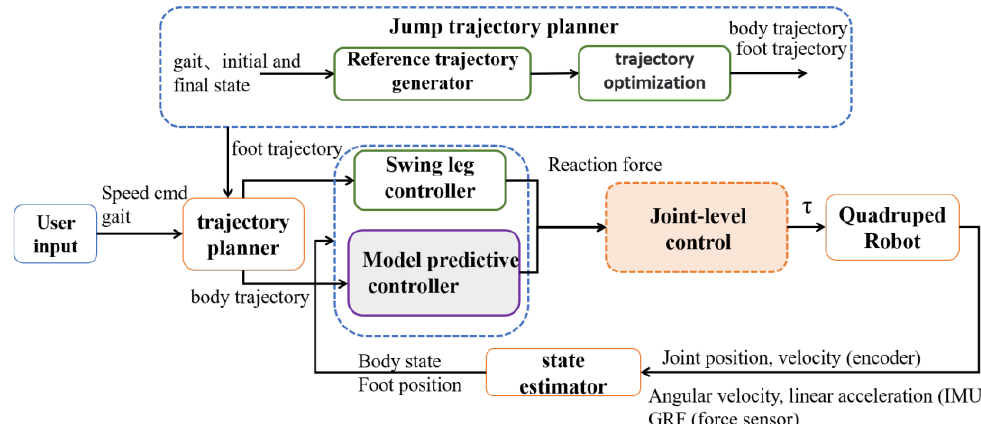
Figure 8. Control framework. The MPC runs at 100 Hz. The joint controller runs at 1